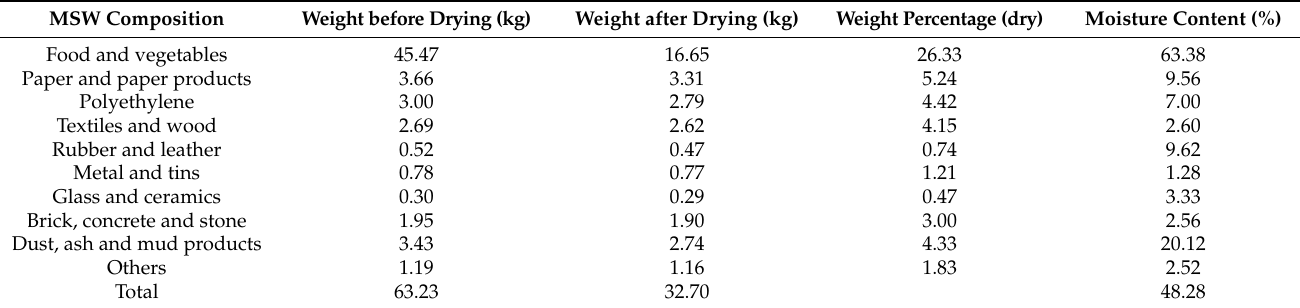
Table 7. Moisture contents of different MSW components collected from seven families. MSW